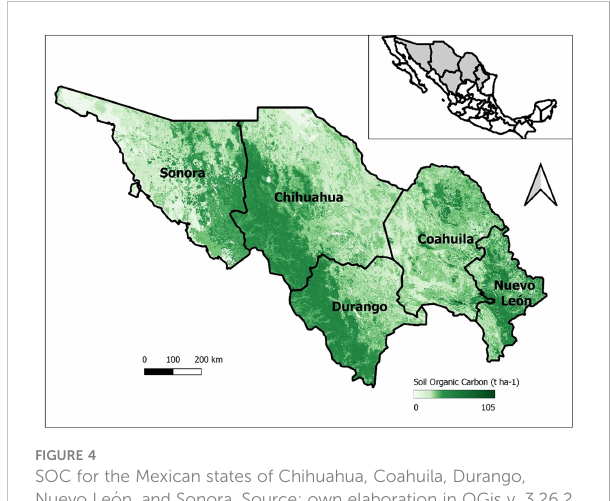
FIGURE 4 SOC for the Mexican states of Chihuahua, Coahuila, Durango, Nuevo Leo ́ n, and Sonora. Source: own elaboration in QGis v. 3.26.2 (2022) based on the Global Soil Carbon Map (84). The map in the upper right indicates the location of the states in